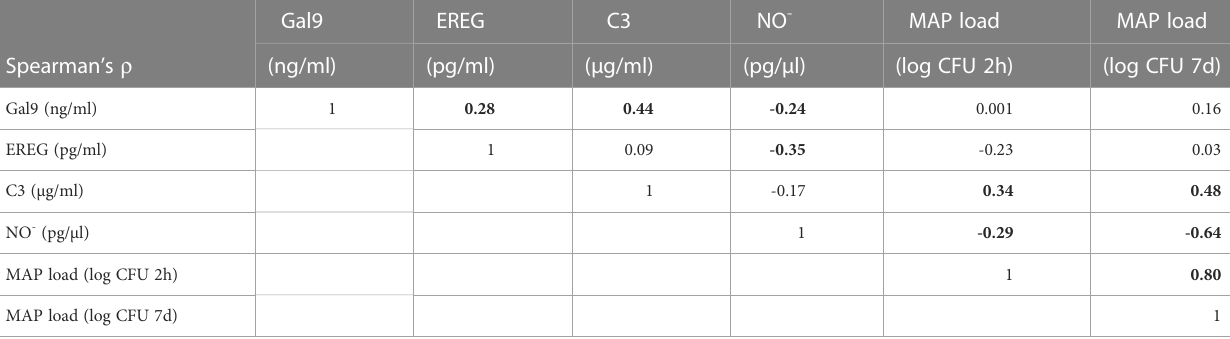
TABLE 1 Spearman ’ s rank correlation coef fi cient ( r ) between the intracellular MAP load within MDMs at 2 h and 7 d p. i., and the extracellular Gal9, EREG, C3, and NO - levels.